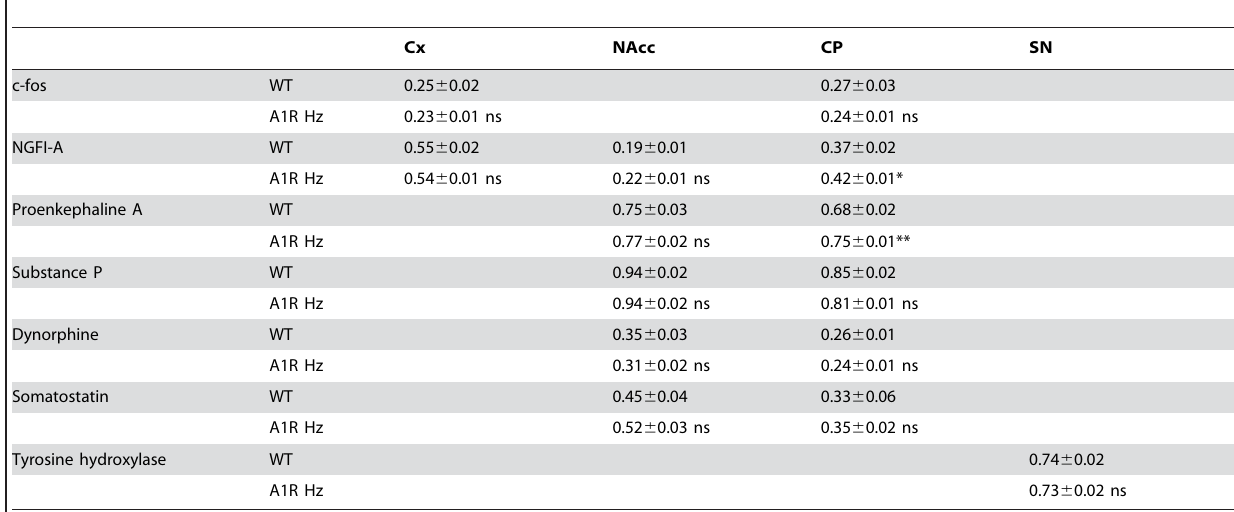
Table 1. Expression of mRNA levels in cocaine-treated offspring to adenosine A 1 R Hz or WT